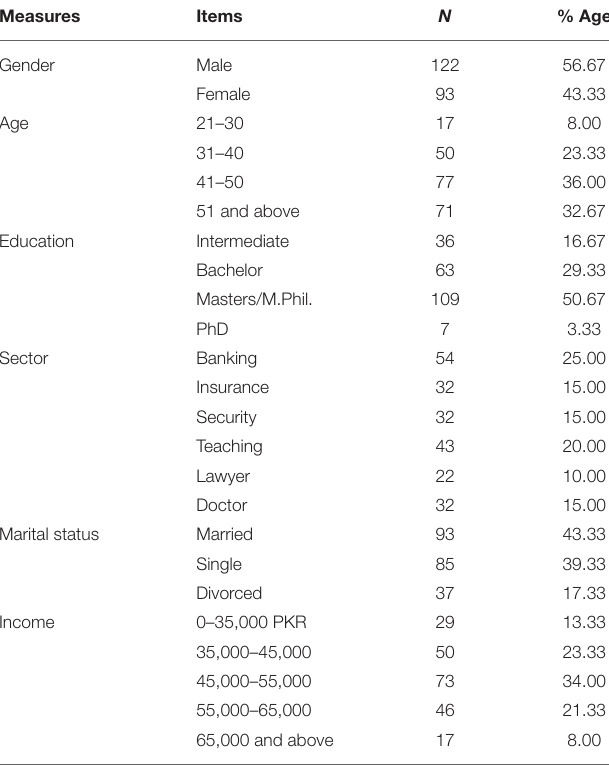
TABLE 1 | Demographic characteristics of respondents. TABLE 2 | Reliability and validity